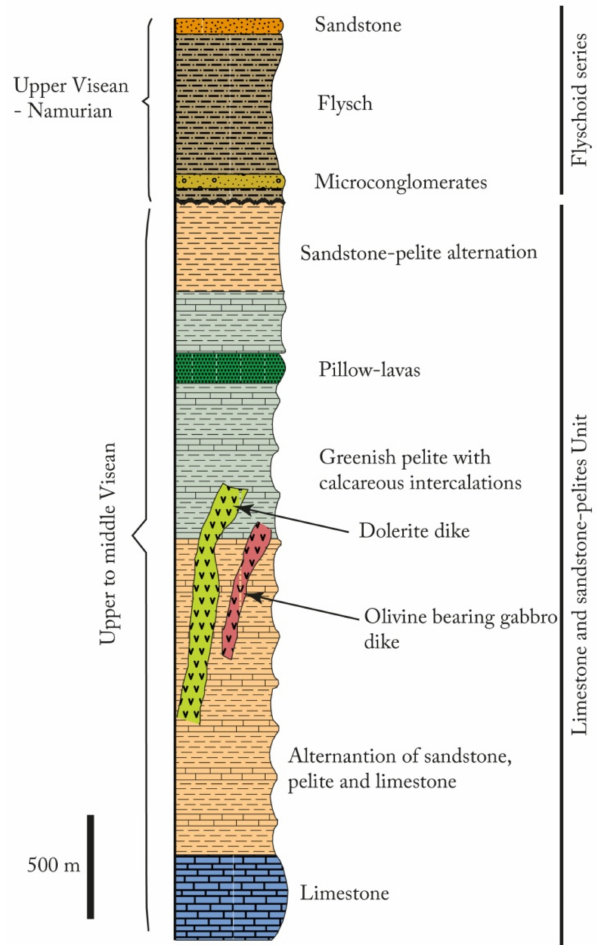
Figure 4. Synthetic lithostratigraphic column of the NNE-A.